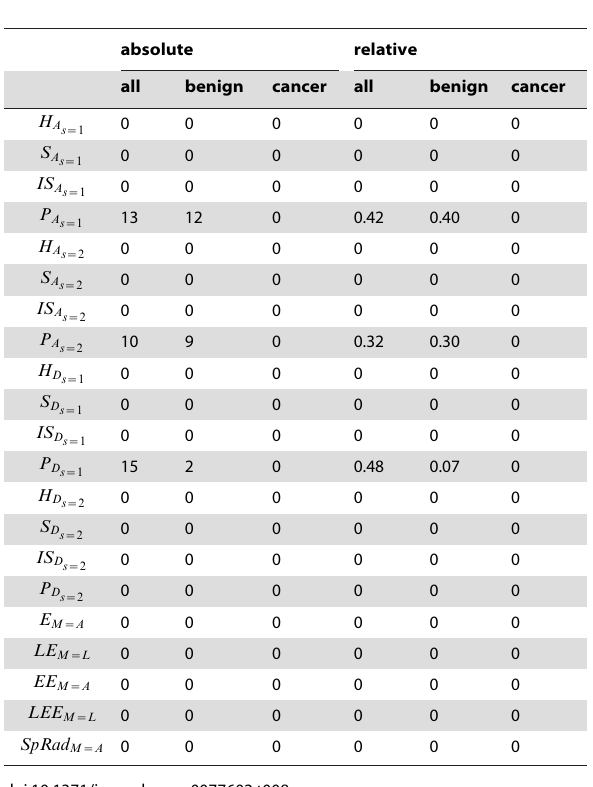
Table 9. ndV-values for the structural biomarkers (eigenvalue and entropy-based measures) for prostate cancer networks and the corresponding subgroups (benign/cancer) for